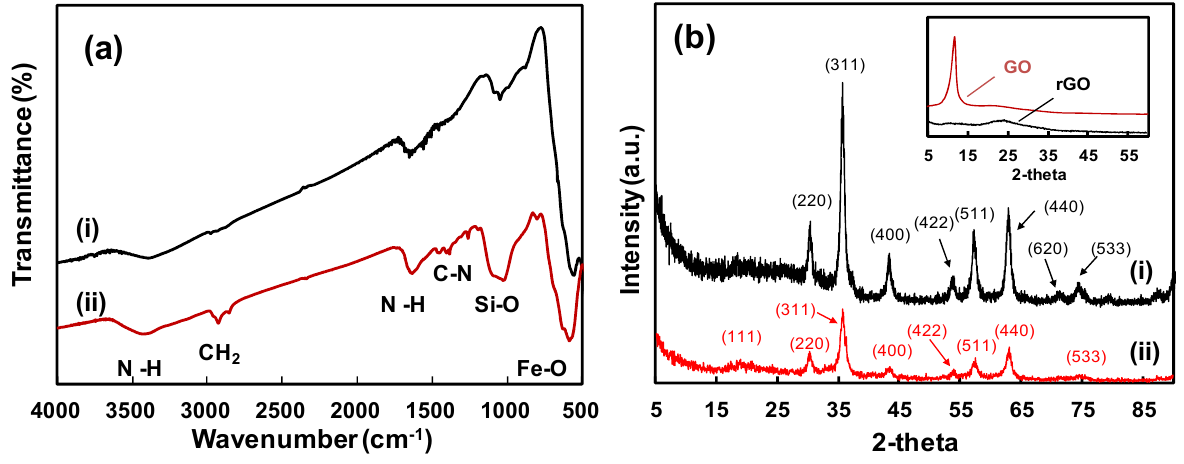
Figure 1. ( a ) Fourier transform infrared spectroscopy (FTIR) spectra: (i) Fe (ii) Fe O -APTMS; ( b ) X-ray diffraction (XRD) patterns: (i) Fe 3 4